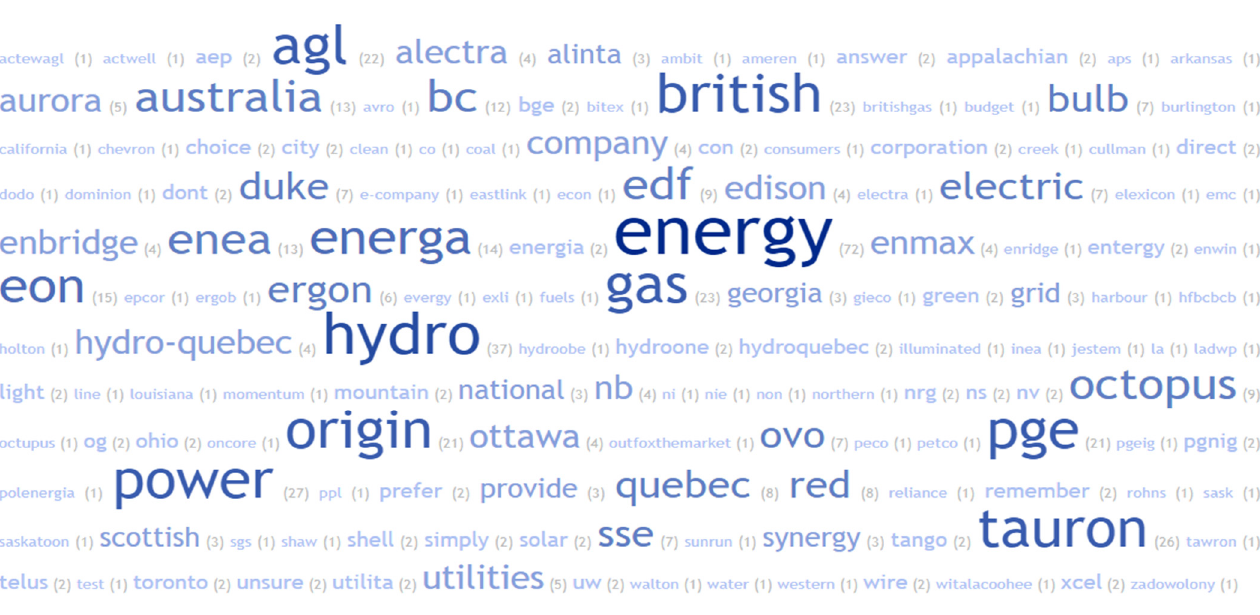
Figure 2. Frequency of the name of the company supplying electricity to B2C. Source: own study. Hypothesis 1 (H1). Clean energy vs. customer preferences .